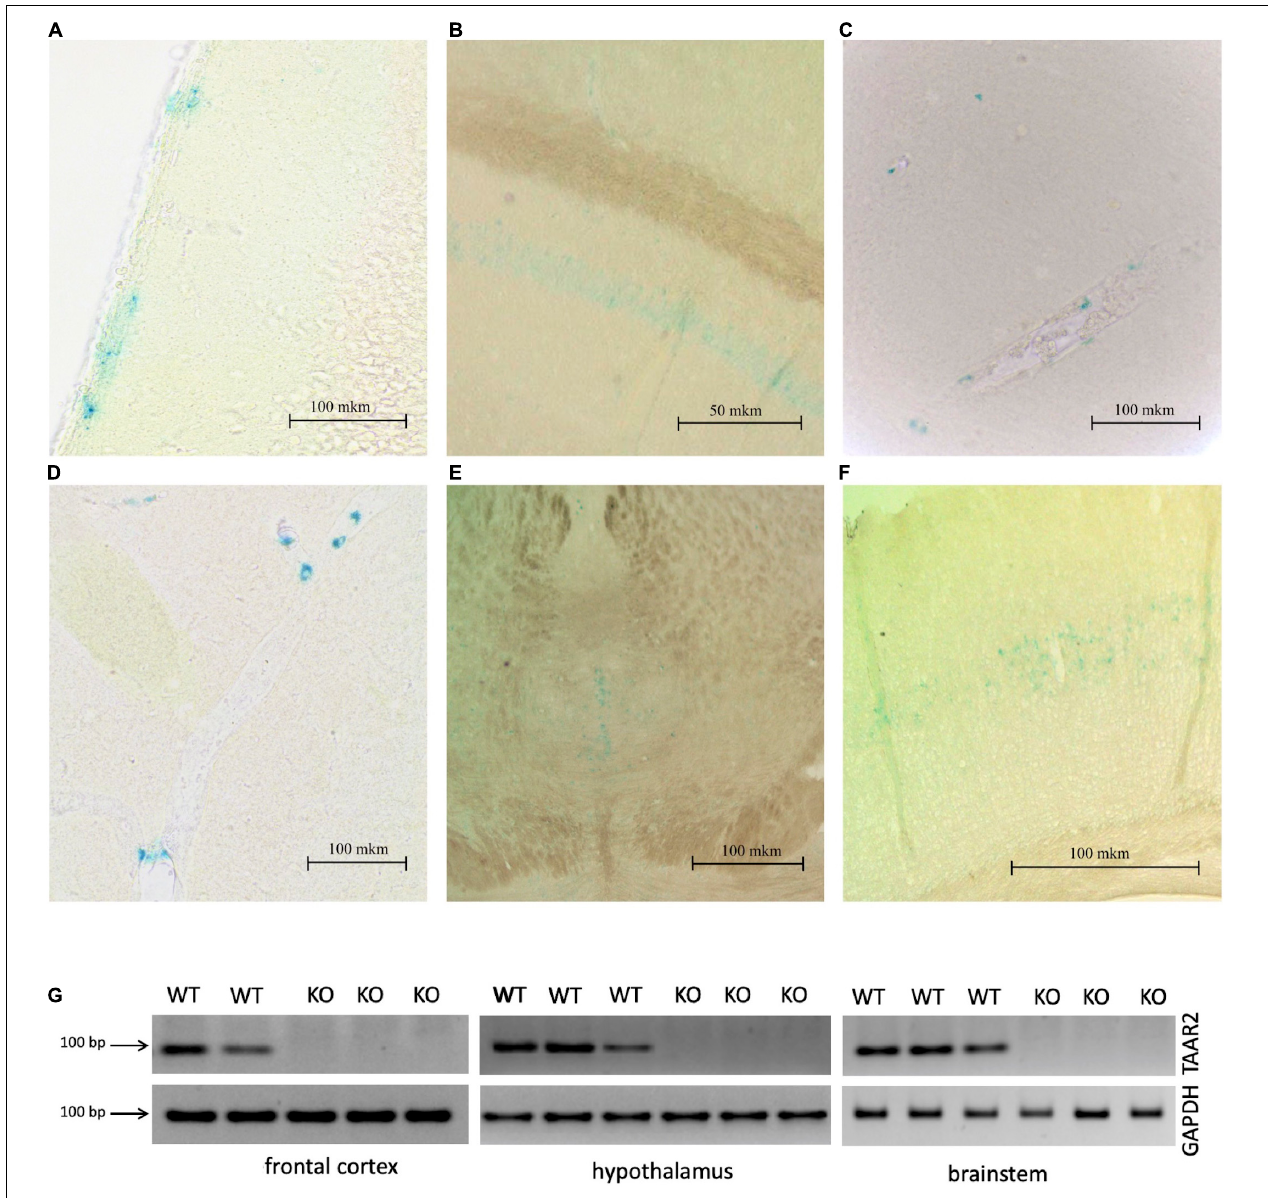
FIGURE 3 | | LacZ staining shows TAAR2 expression in the mouse piriform cortex (A) , hippocampus (CA1 layer) (B) , hypothalamus (C) , lateral habenula (D) , raphe nucleus (E) , somatosensory cortex, layer 5 (F) , Scale bar—50 µ m (B) ; 100 µ m (A,C,D–F) . (G) mRNA expression level of TAAR2 in wild type and TAAR-2 KO in frontal cortex, hypothalamus, and brain